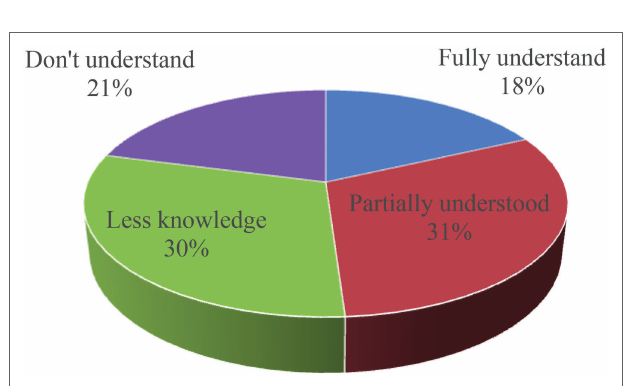
FIGURE 5 | Residents’ understanding of community mental health